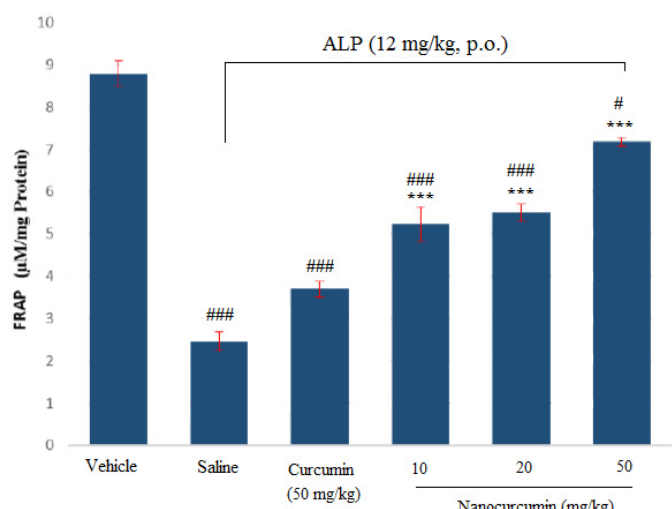
Fig. 5. Effects of curcumin and nanocurcumin on FRAP levels in ALP-intoxicated rats. # P<0.05 and ### P<0.001 significantly different from vehicle. *** P<0.001 significantly different from control group (ALP + saline).